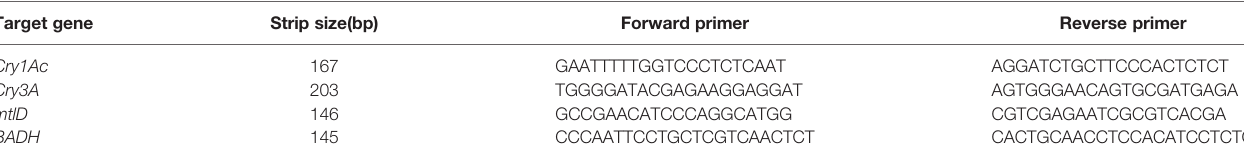
TABLE 2 | Fluorescence quantitative PCR detection primers for target